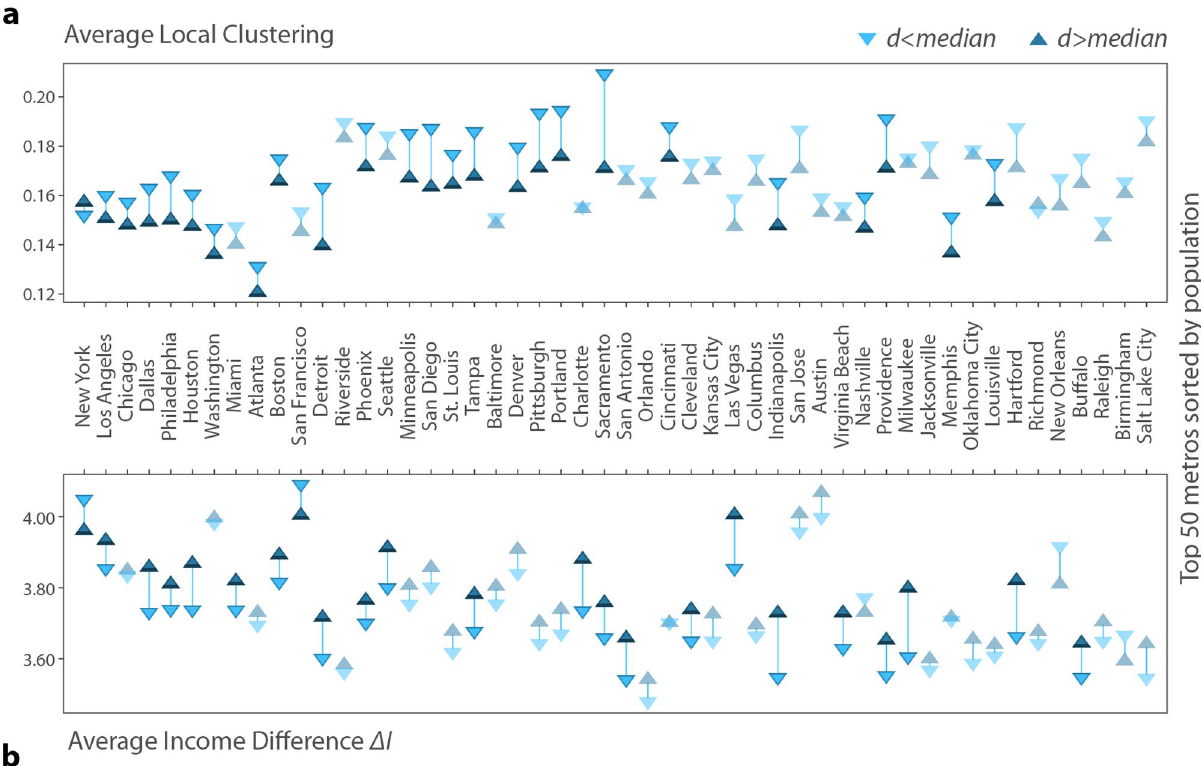
Figure 2. Network characteristics of users and commuting distance in the top 50 metropolitan areas of the United States. ( a ) Network closure measured by the local clustering coefficient is lower in most cities for those users who commute further than the local median distance. ( b ) Income mixture, measured by average income difference from friends, is higher of those who commute above the local median distance in the majority of metropolitan areas. Non-transparent symbols indicate that t-tests suggest significantly different means for the groups ( p < 0.05 )